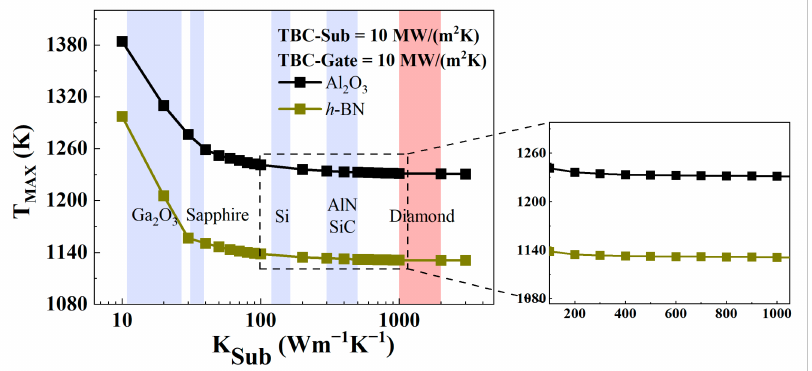
Figure 6. The dependence of T MAX on K Sub as both the TBC-Sub and TBC-Gate are kept at 10 MWm − 2 K − 1